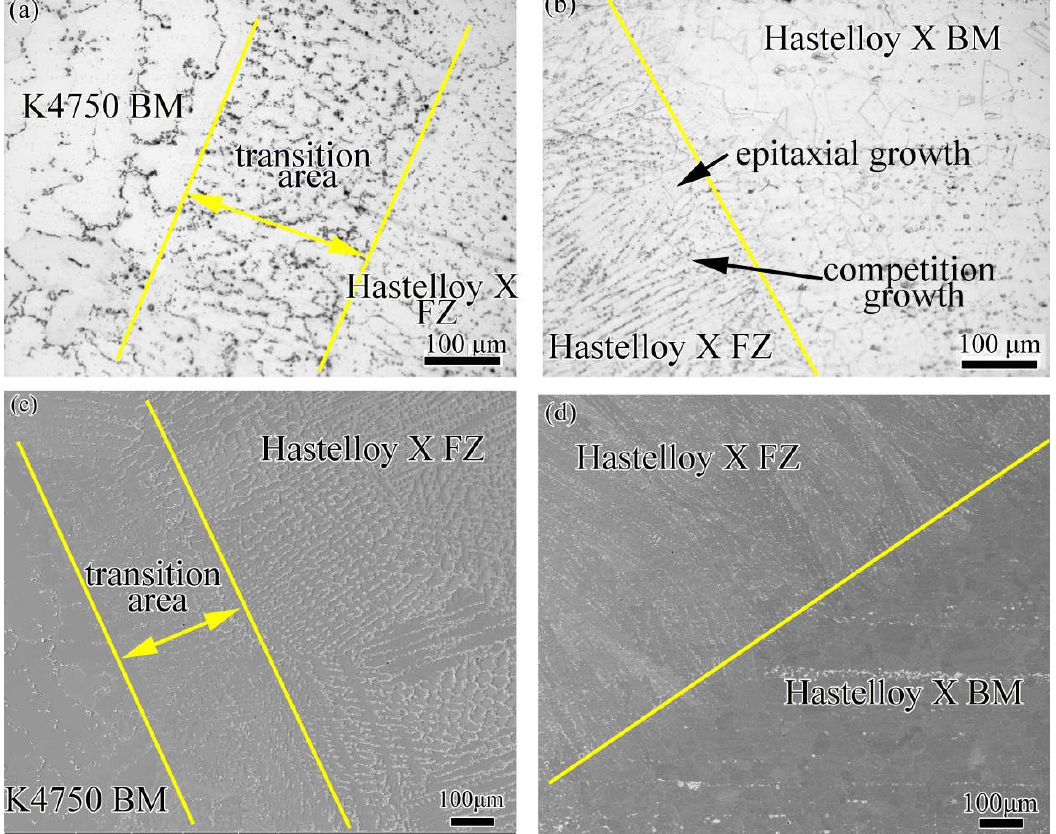
Figure 8. Interfacial characteristics of dissimilar joints with Hastelloy X filler material ( a ) OM image of K4750 (BM) base metal and Hastelloy X (FZ) fusion zone interface; ( b ) OM image of Hastelloy X BM and Hastelloy X FZ interface; ( c ) SEM image of K4750 BM and Hastelloy X FZ interface; and ( d ) SEM image of Hastelloy X BM and Hastelloy X FZ interface.